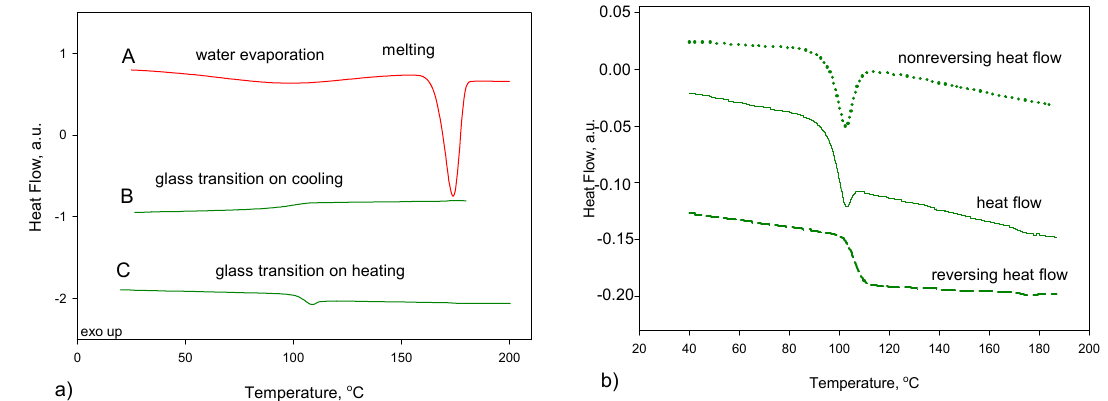
Figure 2. The experimental ( a ) differential scanning calorimetry (DSC) data of the heat-flow rate vs. temperature for indapamide. A—1st heating run for hemihydrate crystalline material (red), B—cooling run from the melt (green), C—heating run of amorphous indapamide (IND) (green) and ( b ) temperature-modulated differential scanning calorimetry (TMDSC) data of the heat-flow rate vs. temperature for the heating run of amorphous IND. Total heat-flow curve (green solid)—showing the glass transition process overlapped with the enthalpy relaxation peak, reversing the heat-flow curve (green dashed)—showing the glass transition process only and nonreversing the heat-flow curve (green dotted)—showing the enthalpy relaxation peak only.